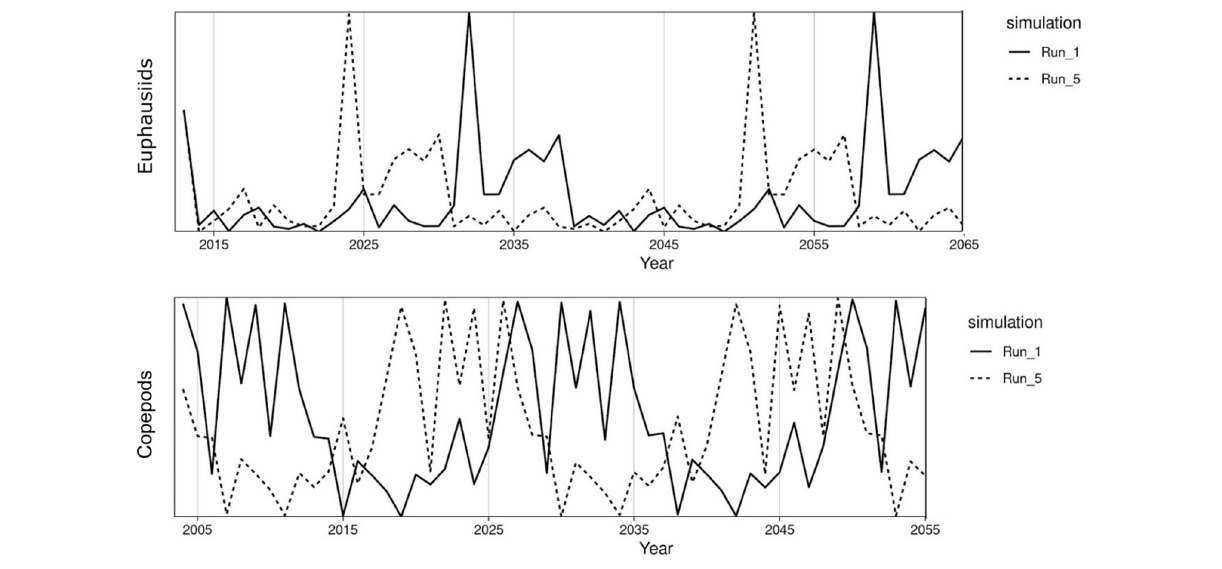
FIGURE 3 | Biomass trajectories of euphausiids from the California Current Atlantis model (top) and of copepods from the Nordic and Barents Seas Atlantis model (bottom) . For each ecosystem, simulations 1 and 5 are shown as examples. The pattern is shifted by 2 years between each simulation, e.g., simulations 1 and 5 are 8 years lagged. Biomass trajectories are forced based on zooplankton abundance time series for the Norwegian Sea (copepods, 1995–2017), and the California Current (euphausiids, 1990–2017), with the time series “looped” to stretch the duration of the Atlantis